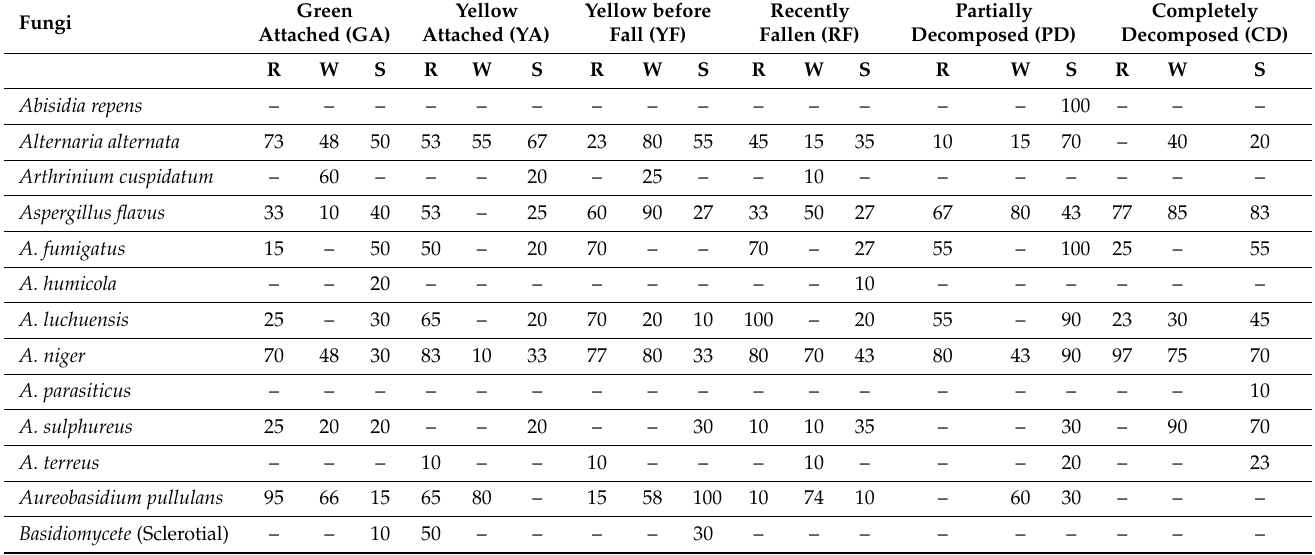
Table 7. Average percentage frequency of occurrence of various fungi at different decomposition stages of the leaves in different